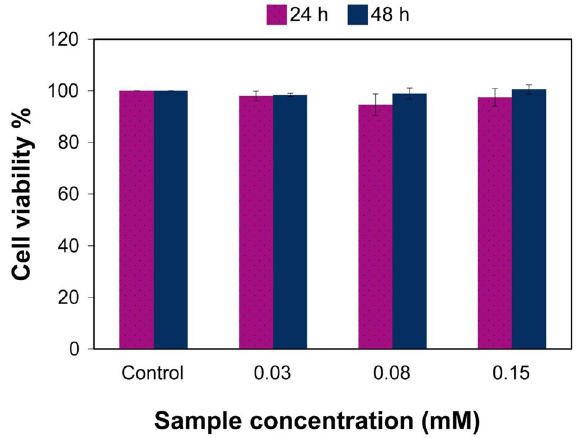
Figure 4. Viability of A431 human epidermis cells by MTT assay after 24 and 48 h post cell treatment with 0.03, 0.08 and 0.15 mM Alg-Fib@Nis-EDTA (nisin based concentrations). Cell viabilities are normalized to the control cells and represent the mean ± SEM. n = 3. SEM: standard error of